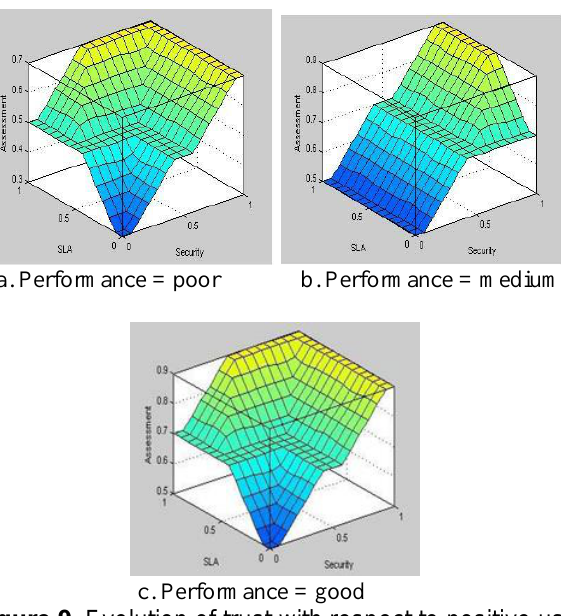
Figure 9. Evolution of trust with respect to positive user